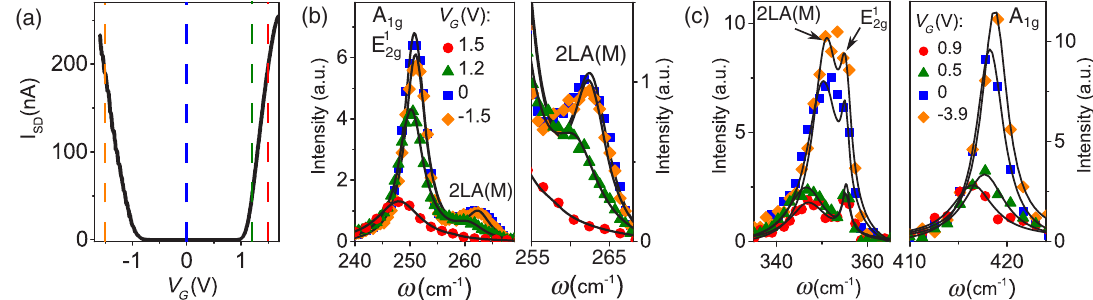
FIG. 2. (a) Source-drain current I as a function of gate voltage V measured on a WSe 2 monolayer (source-drain bias G SD ¼ 50 mV), exhibiting clear ambipolar transport. This curve is measured in situ , with the device mounted in the setup used to V SD perform Raman spectroscopy, and it enables us to estimate the density of carriers at any given value of V as discussed in the main text. G (b) Left panel: Raman spectrum of the WSe 2 monolayer at selected gate voltages indicated in the legend and corresponding to the values of V marked with the dashed lines of different colors in panel (a). The peak near 250 cm − 1 originates from the degenerate A 1 and E 2 G g g modes, and the one near 250 cm − 1 is due to a resonant electronic process involving the LA(M) mode. In all cases, the black lines are fits of the data to Lorentzian-shaped peaks centered around the energy of the different modes identified. (b) Right panel: Zoom-in on the spectral region around the peak due to the resonant process involving the LA(M) mode. (c) Left panel: Peaks in the Raman spectrum of the WS 2 bilayer originating from the E 2 and 2LA(M) modes for different values of gate voltage (see the legend in the right panel). g (c) Right panel: Peak in the Raman spectrum due to the A 1 mode measured at the gate voltages indicated in the legend (black lines are g fits of the data obtained by introducing a Lorentzian-shaped peak for each one of the modes involved). As for the WSe 2 monolayer, the spectra are strongly affected upon electron accumulation; the A 1 and 2LA(M) modes shift to lower wave numbers (i.e., softening) and g decrease in intensity, whereas they are left virtually unchanged upon hole accumulation. The position of the E 2 peak remains constant g for both electron and hole